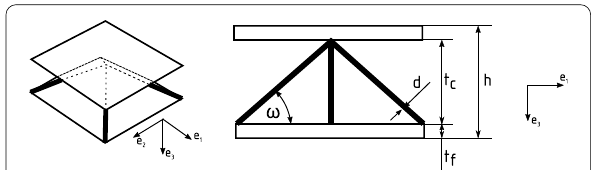
Figure 2 Unit cell of sandwich structures with geometric parameters